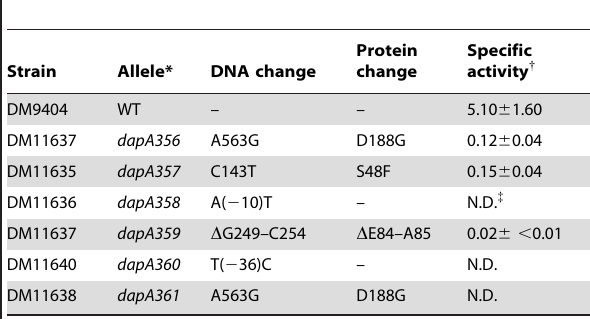
Table 2. Suppressing DapA variants have decreased specific